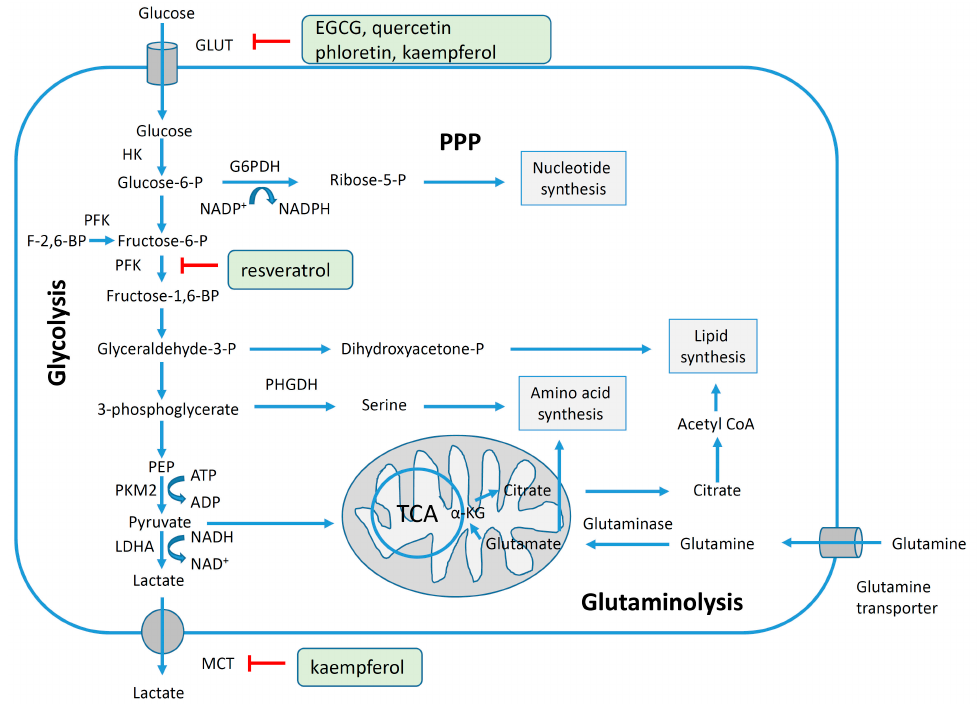
Figure 2. Schematic representation of glycolysis, the pentose phosphate pathway (PPP), glutaminolysis and lipid synthesis and their inhibition by polyphenols in breast cancer cells. During glycolysis, glucose enters the cell through the glucose transporter (GLUT) and then it is oxidized to pyruvate followed by reduction to lactate. Lactate is released from the cell through the monocarboxylate transporter (MCT). The rate of aerobic glycolysis in cancer cells is increased in detriment of ATP production. The intermediate compounds from the glycolytic pathway are further used to synthetize nucleotides, amino acids and lipids required for the proliferation of cancer cells [72,75,76,80]. The glucose transporter can be inhibited by EGCG, quercetin, phloretin, kaempferol [81–83], PFK by resveratrol [84], and MCT by kaempferol [83]. Abbreviations: PEP, phosphoenolyruvate; TCA, tricarboxylic acid cycle; F-2,6-BP, fructose-2,6-biphosphate; α -KG, alpha-ketoglutarate; HK, hexokinase; G6PDH, glucose-6-phosphate dehydrogenase; PFK, phosphofructokinase; PHGDH, 3-phosphoglycerate dehydrogenase; PKM2, pyruvate kinase isoform M2; LDHA, lactate dehydrogenase A; Acetyl CoA, acetyl coenzyme A; ADP, acid adenosine diphosphate; ATP, acid adenosine triphosphate; NADP+, nicotinamide adenine dinucleotide phosphate (oxidized); NADPH, reduced nicotinamide adenine dinucleotide phosphate; NADH, reduced nicotinamide adenine dinucleotide; NAD+, nicotinamide adenine dinucleotide (oxidized). Administration of resveratrol induced the dissociation of the tetrameric PFK-M isoform, isolated from rabbit skeletal muscle to a less active form, the dimer [84]. Glucose uptake was investigated in MCF-7 and MDA-MB-231 breast cancer cells using 3 H-2-deoxy- D -glucose ( 3 H-DG). The consumption of 3 H-DG in breast cancer cells was found to be suppressed by cytochalasin B, a glucose transporter inhibitor, moderately stimulated by insulin and independent of sodium suggesting that it was mainly mediated by the GLUT family of transporters rather than by sodium-glucose transporter. Administration of EGCG and quercetin suppressed 3 H-DG uptake in a concentration-dependent manner in both cells lines and inhibited lactate production only in MCF-7 cells, suggesting that EGCG and quercetin might be considered possible therapeutic/adjuvant agents in breast tumors [81]. Recent data demonstrated that two flavonoids, quercetin and phloretin (0.6–300 µM) inhibited glycolysis indicated by increased glucose and decreased lactate concentrations in the cell culture media of MCF-7 and HBL100 breast cancer cells after 24 h of exposure [82]. The effect of several polyphenols (myricetin, chrysin, genistein, resveratrol and kaempferol with concentration range 10–100 µM) was investigated in a short-term